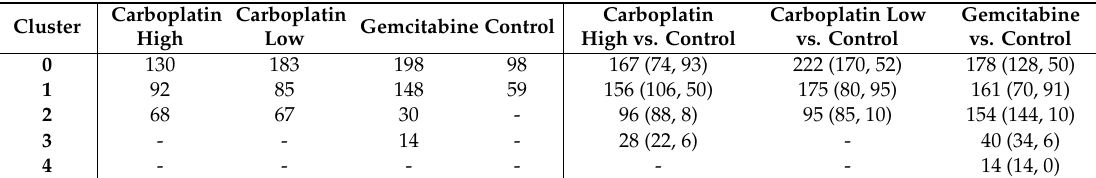
Table 4. The number of cells in the identified